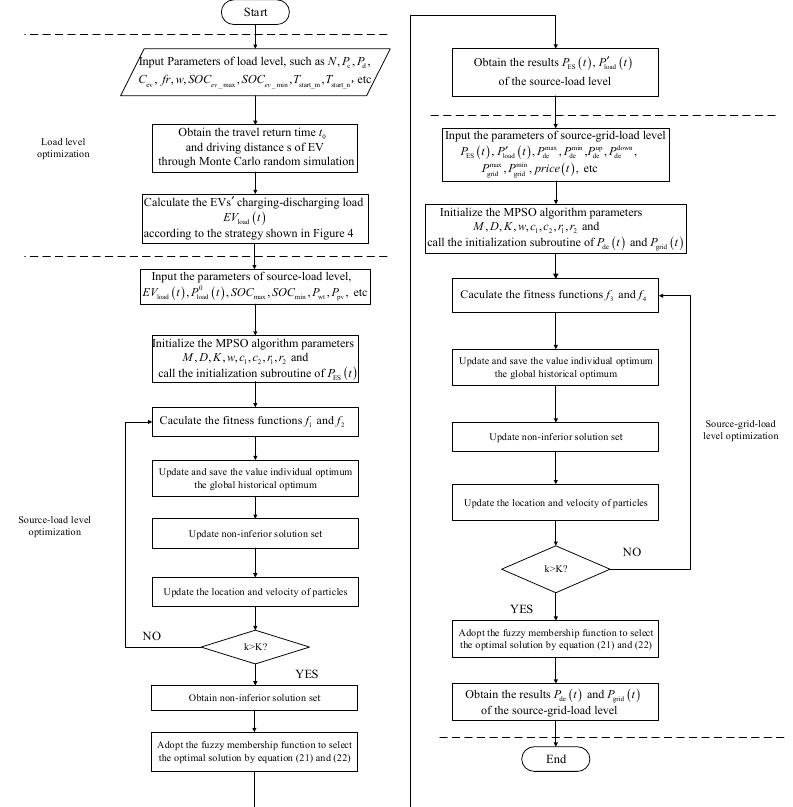
Figure 5. Flow chart of the MG multiobjective hierarchical joint economic dispatching strategy.